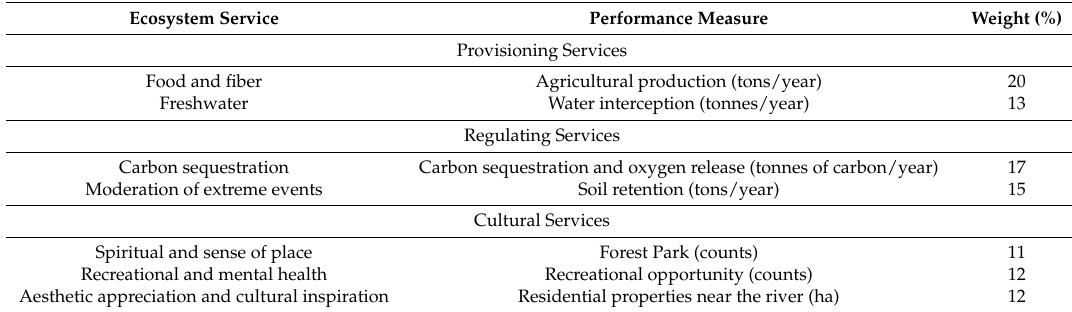
Table 4. The weight for each ecosystem services derived from the survey data.